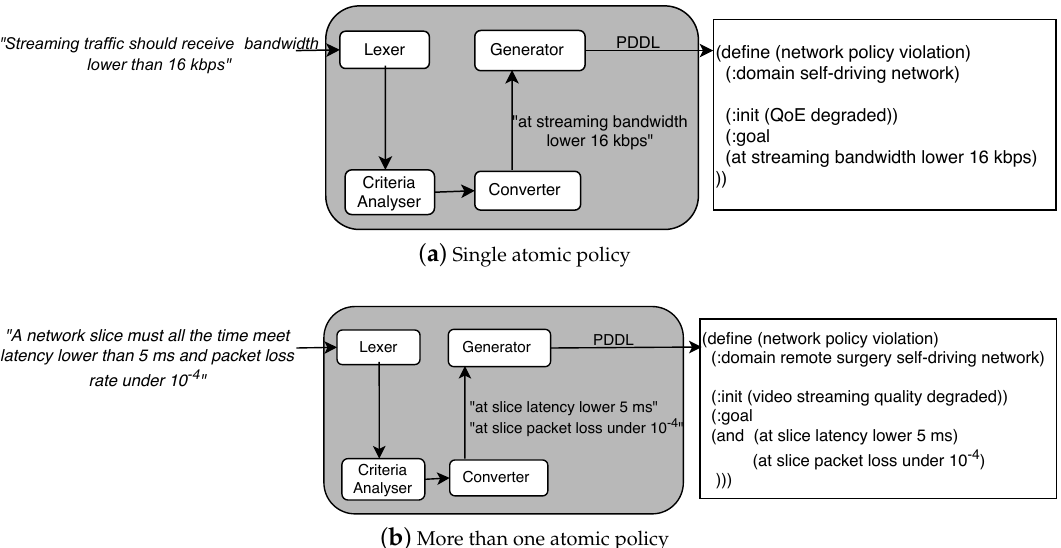
Figure 3. NORA—High-level